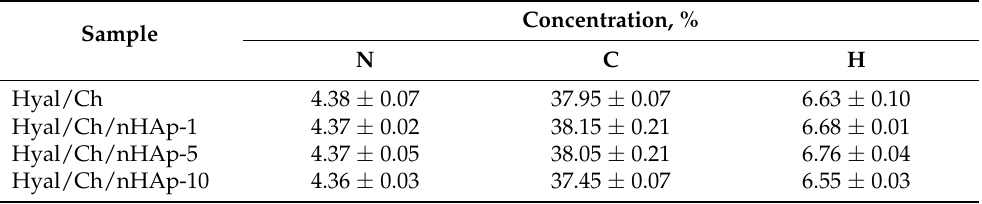
Table 1. Elemental analysis data and the calculated composition of polymer matrix.